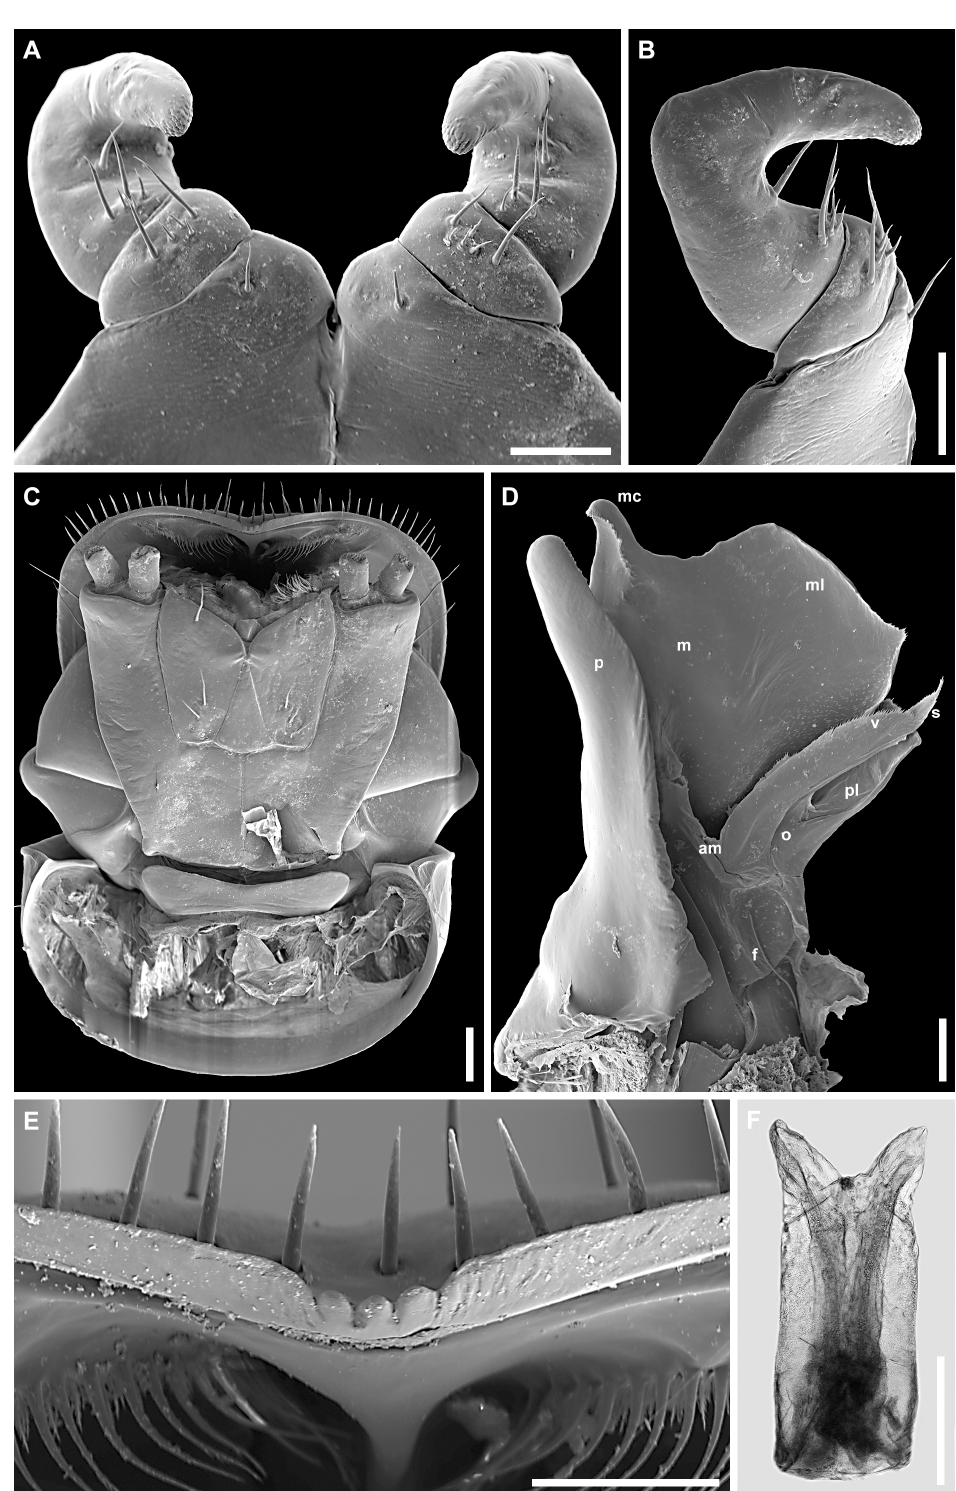
Fig. 12. Leucogeorgia rediviva Golovatch, 1983, ♂ from Khabyu Cave (SMNG). A . Leg-pair 1, anterior view. B . Left leg 1, lateral view. C . Head, ventral view. D . Left gonopods, mesal view. E . Detail of labrum, ventral view. F . Penes, posterior view. Abbreviations: am = accessory membrane; f = flagellum; m = mesomere; mc = mesomeral claw; ml = mesomeral lamella; o = opisthomere; p = promere; pl = protective lamella; s = solenomere; v = velum. Scale bars: A–B, D–E = 0.1 mm; C, F = 0.2